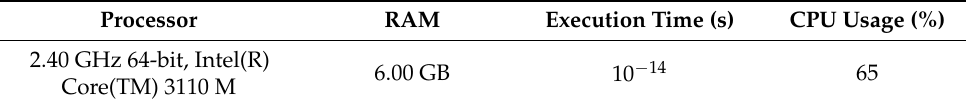
Table 3. Proposed smart irrigation system complexity